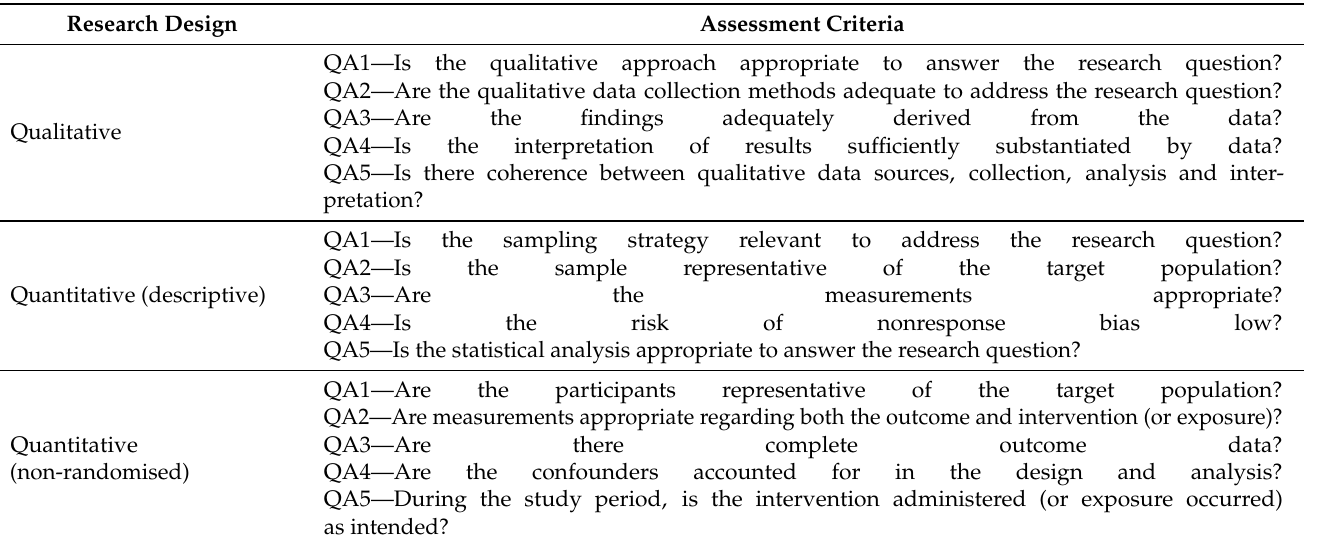
Table A1. The Criteria Used to Determine the Rigour of the Methodology and Analysis Used in the Selected